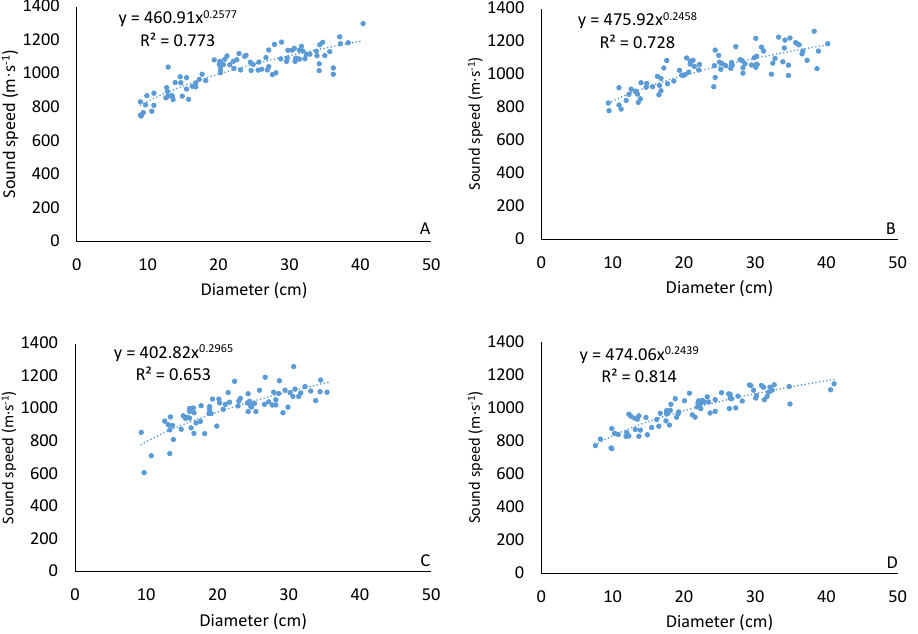
Figure 7. Relationship between diameter and sound speed differentiated on planting variants ( A ) V1, 2500; ( B ) V2, 3330; ( C ) V3, 5000; ( D ) V4, 7510 trees·ha −1 . Table 5. General statistical parameters (average, standard deviation, variation coefficient — %, asym- metry, excess, minimum and maximum) for sound speed (m · s −1 ).